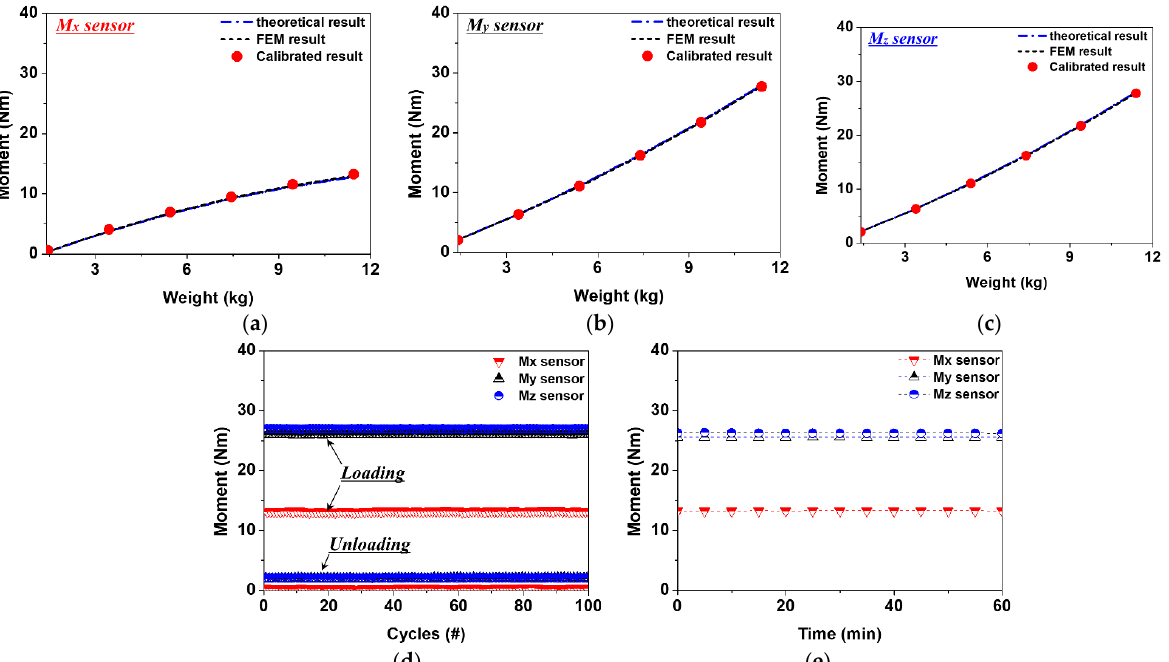
Figure 8. The three-axis sensor according to weight change and evaluation of sensor characteristics: ( a ) hysteresis result of Mx sensor; ( b ) hysteresis result of My sensor; ( c ) hysteresis result of Mz sensor; ( d ) evaluation of the repeatability; ( e ) evaluation of the drift characteristics.